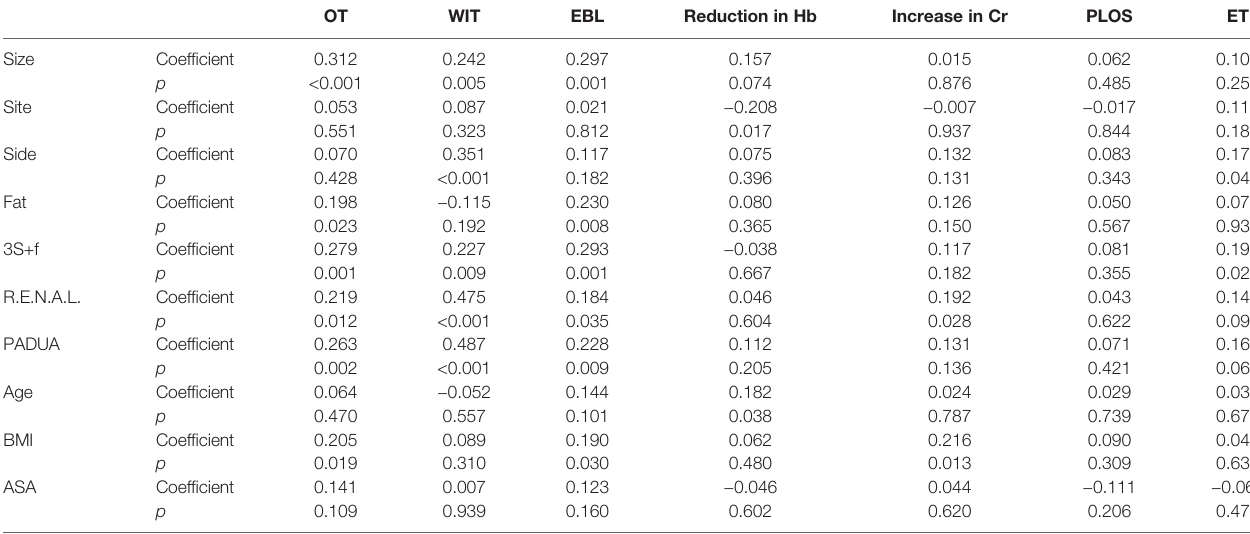
TABLE 3 | Spearman correlation analysis between variables and clinical